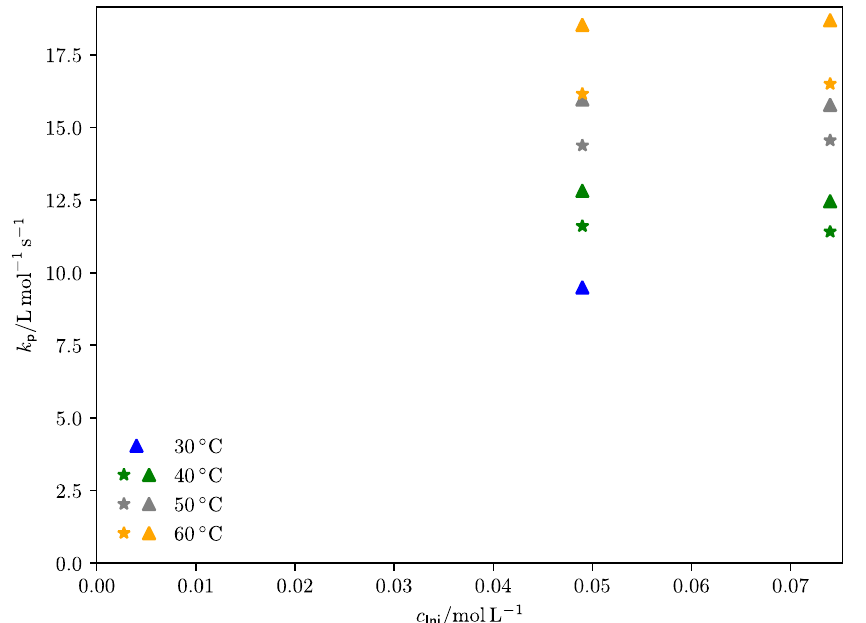
Figure 6. Obtained propagation rate coefficients for DnPI as a function of initiator concentration, c Ini . An average of the k p values extracted from the different inflection points is used here. Stars refer to a laser repetition rate of 0.25 Hz, while triangles refer to 0.5 Hz.